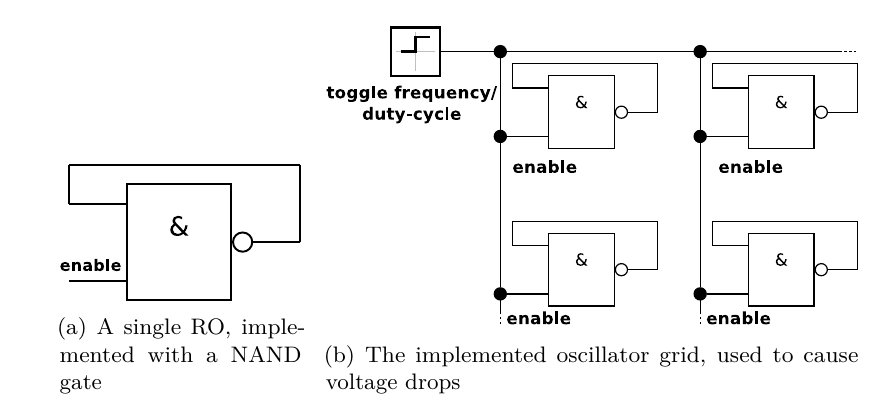
Figure 4: Schematics of the RO